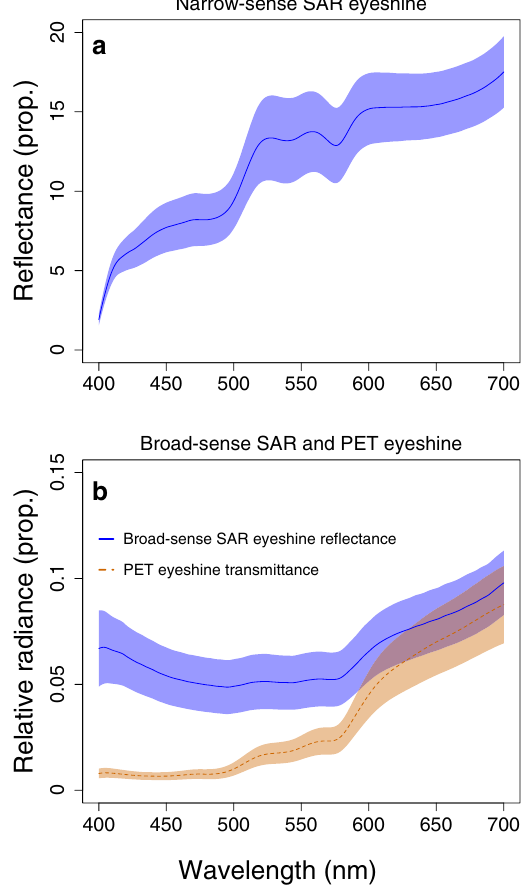
Figure 4. Wavelength dependent contribution of eyeshine types in Scorpaena porcus . ( a) Narrow-sense SAR eyeshine reflectance. (b) Broad-sense SAR eyeshine reflectance and PET eyeshine transmittance. Y-values are expressed as proportions of the pupil photon radiance normalized by the radiance of the associated PTFE white standard. Shaded areas represent the standard error of the